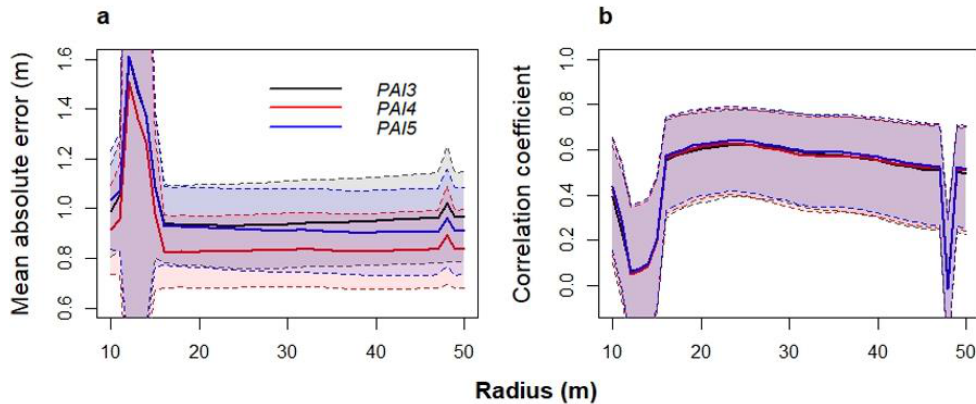
Figure 2. ( a ) Mean absolute error (MAE) and ( b ) Pearson’s correlation coefficient between smartphone and lidar PAI eff estimates across the 10-50m range of radii using a spherical leaf angle distribution in the lidar PAI eff calculation. 95% confidence intervals are plotted for all three curves in ( a , b ). All 42 trail locations are represented in the MAE and correlation coefficient calculations, including trail location images taken by both iPhones.